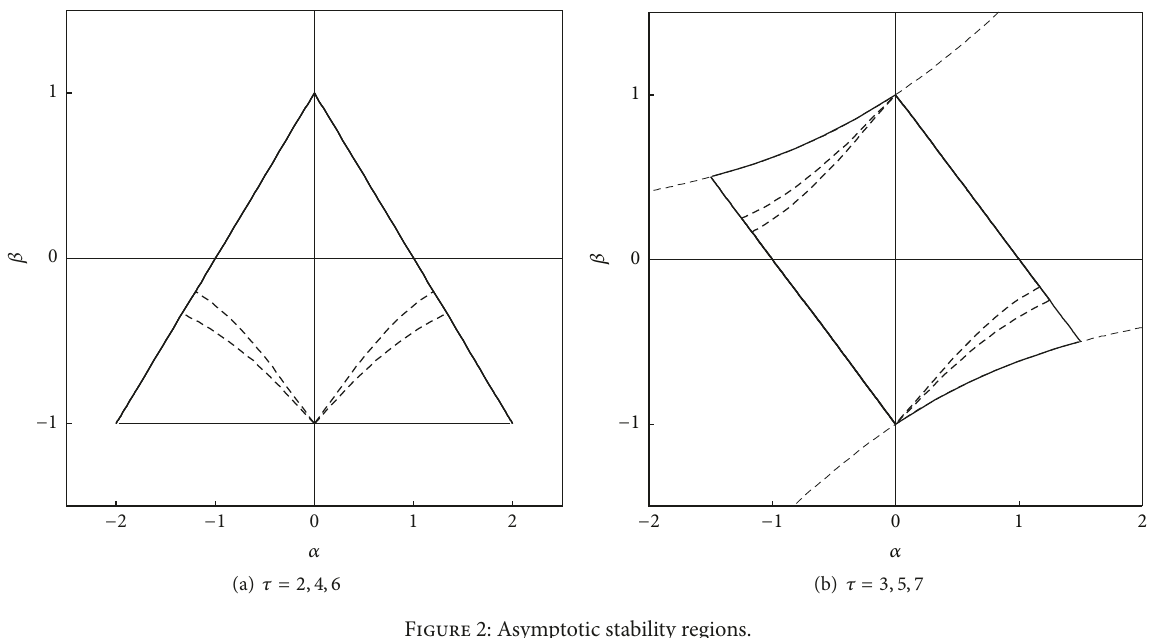
Figure 2: Asymptotic stability